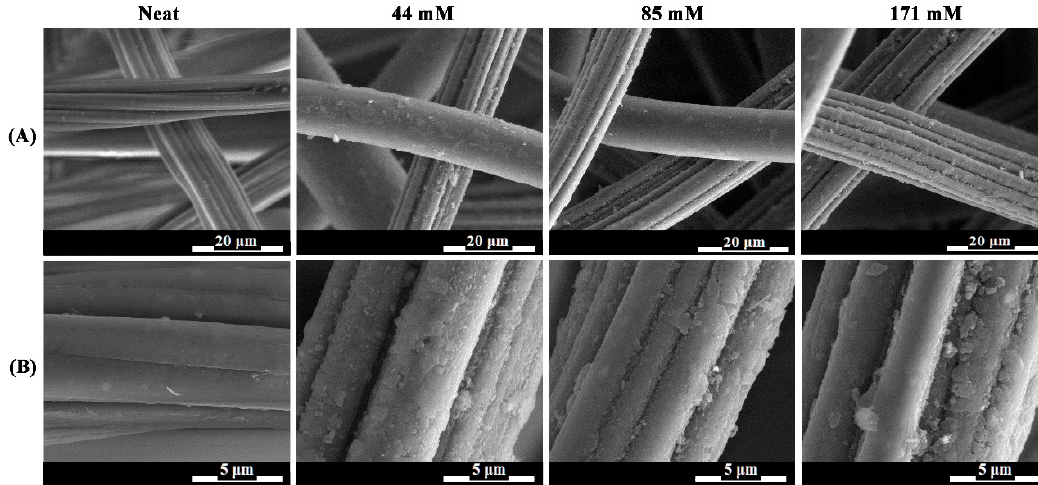
Figure 4. SEM images of 50:50 PET:viscose fabric at 5000× ( A ) and 20000× ( B ).